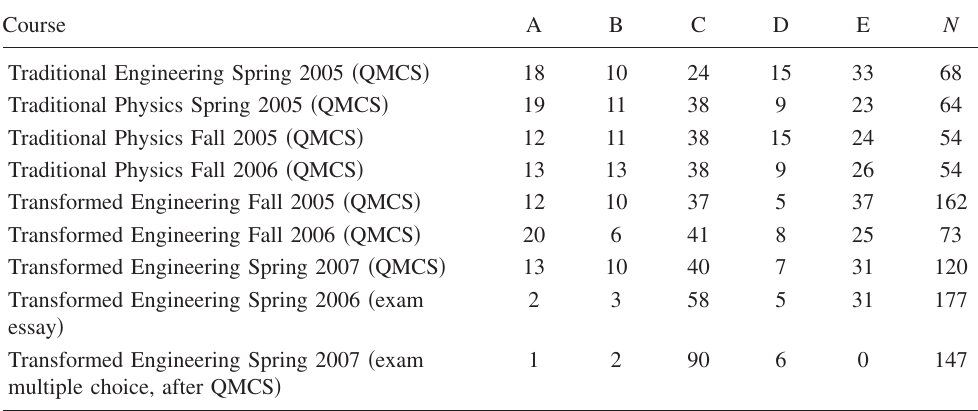
TABLE II. Percentage of students who selected each answer to the question shown in Fig. 7 in various courses. N is the number of